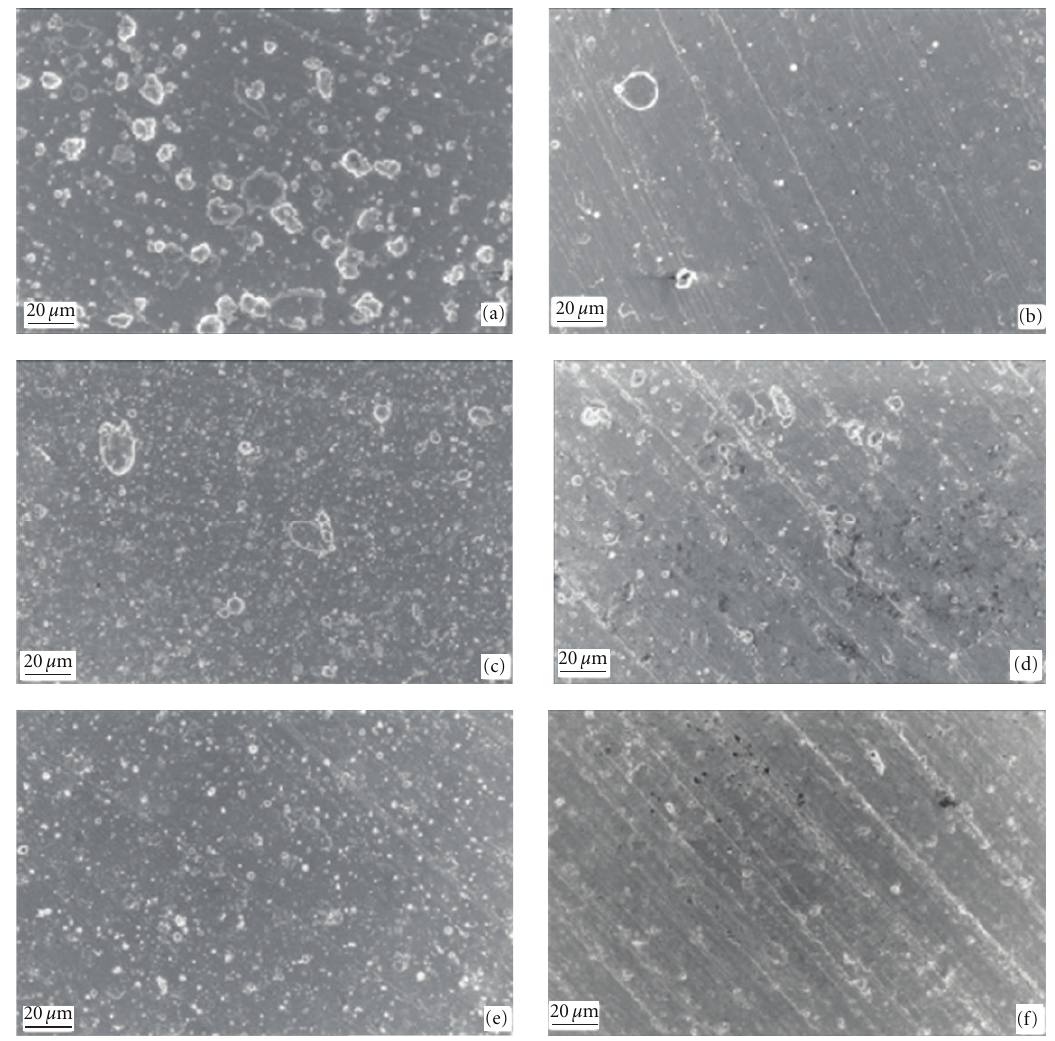
Figure 5: Surface morphology of arc-evaporated interlayers: (a) TiN a, (b) TiN b, (c) TiC, (d) Ti(C, N), (e) CrN, and (f) CrC. Table 1: PVD parameters and thickness of arc evaporated Cr- and Ti-based